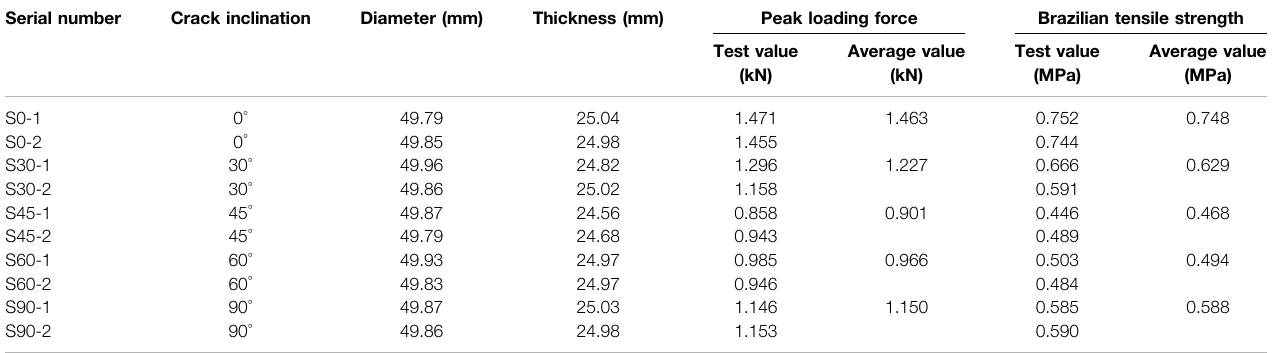
TABLE 1 | Brazilian test results of the sandstone